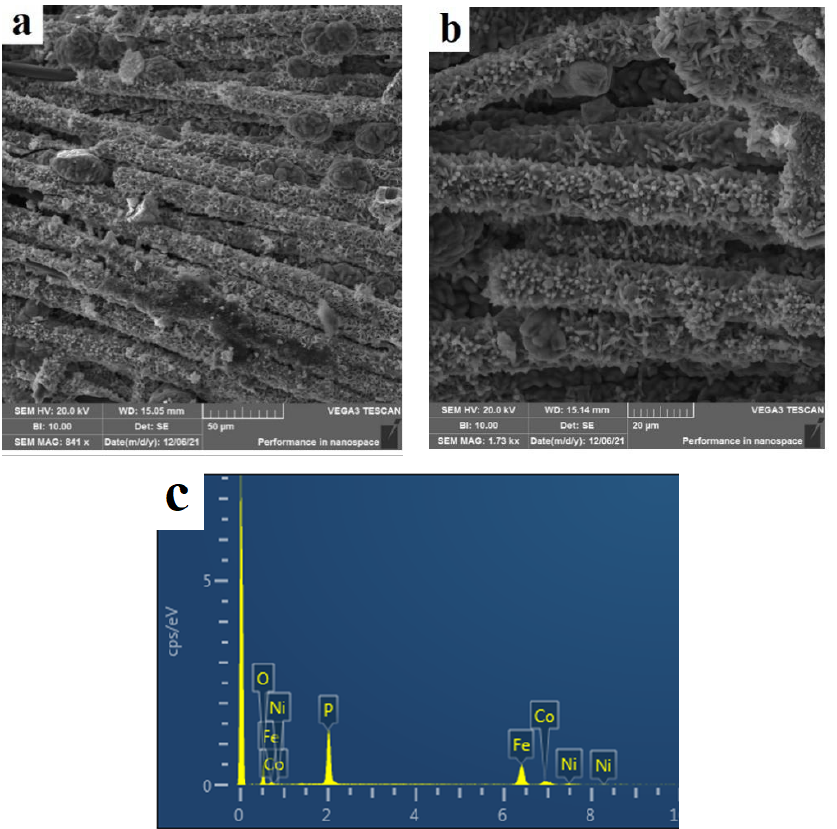
Figure 3. SEM images ( a , b ) and EDX spectrum ( c ) of FeP/CC.